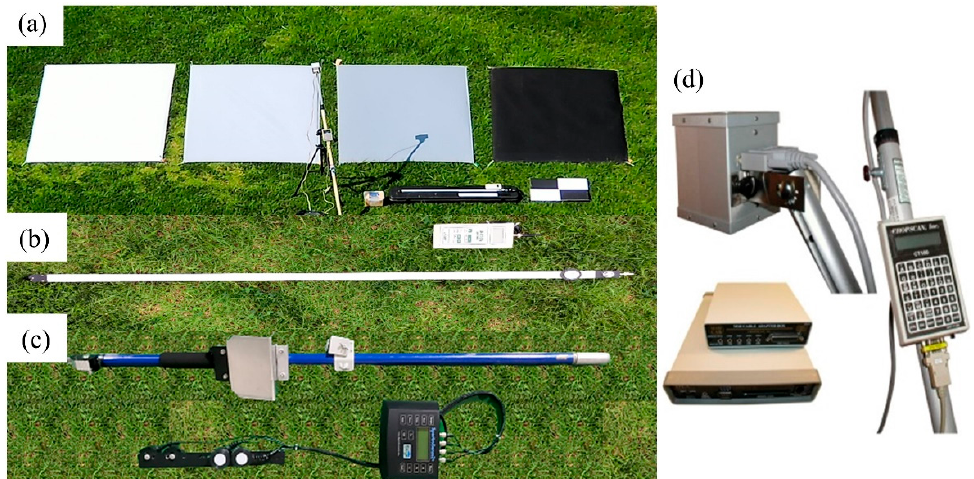
Figure 2. Photograph of the equipment used for radiometric image calibration. ( a ) Four reference tarps with reflectances of 0.51, 0.32, 0.21, and 0.03 from left to right; ( b ) a line quantum sensor (LI-COR, Inc., NE, USA) to measure light intensity; ( c ) a SpectroSense2+ meter (Skye Instruments, Llandrindod Wells, UK); and ( d ) a CropScan radiometer (CropScan Inc., Rochester, MN, USA).